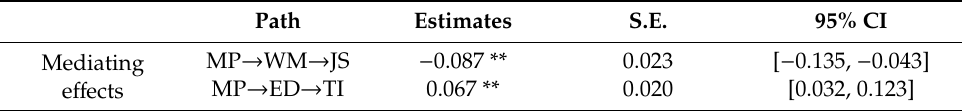
Table 3. Results of hypotheses